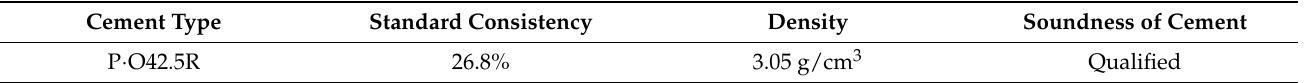
Table 1. Physical properties of cement.